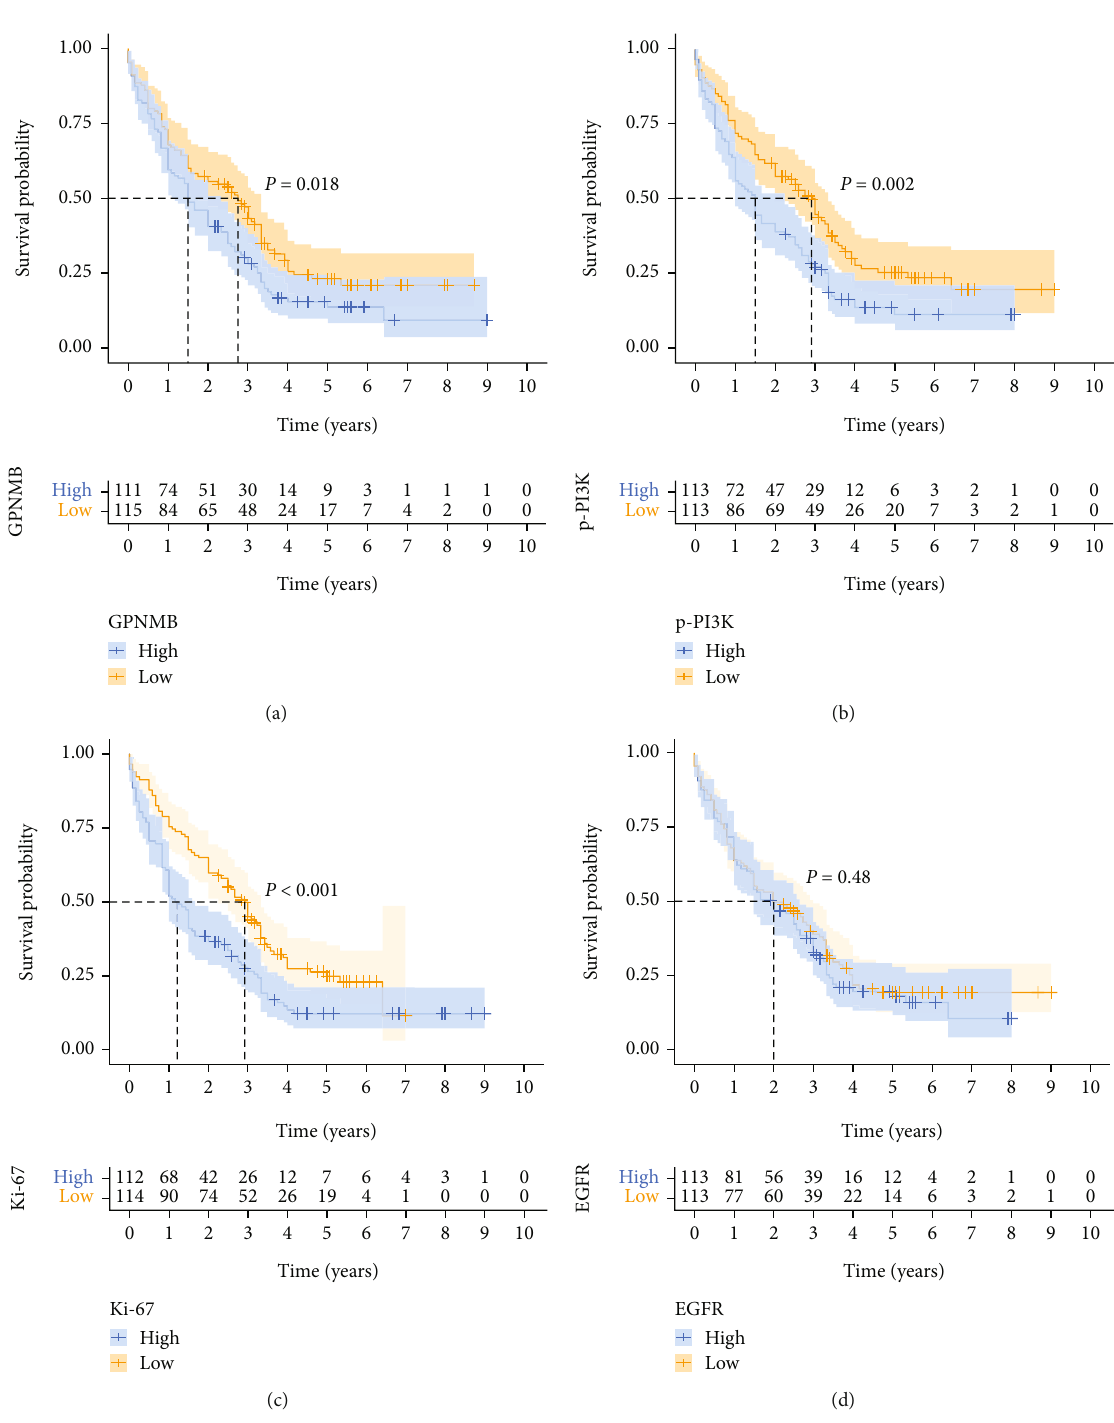
Figure 6: Kaplan – Meier survival curves for patients. The di ff erence in prognosis between the high and low expression groups of (a) GPNMB, (b) p-PI3K, (c) Ki-67, and (d) EGFR. Log-rank test was used to compare the di ff erence between two curves. The pale area around the curve was the 95% con fi dence